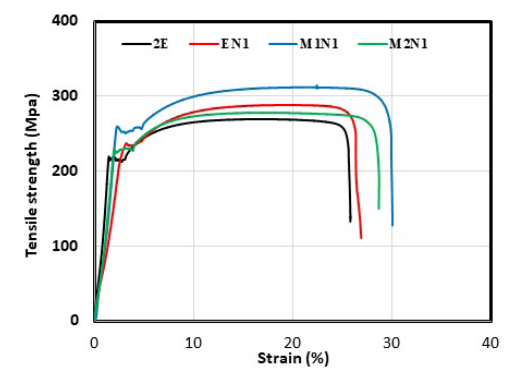
Figure 3. Ultimate tensile strength of steel lined with epoxy filled with Al